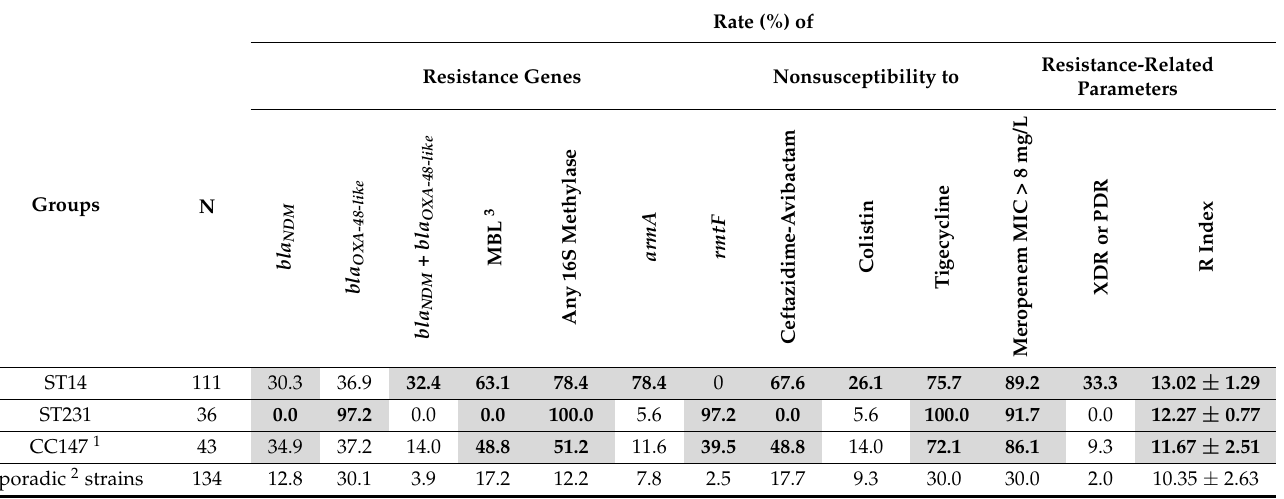
Table 3. Selected features of major Klebsiella pneumoniae clones encountered between 2009 and 2015 as compared with sporadic isolates.